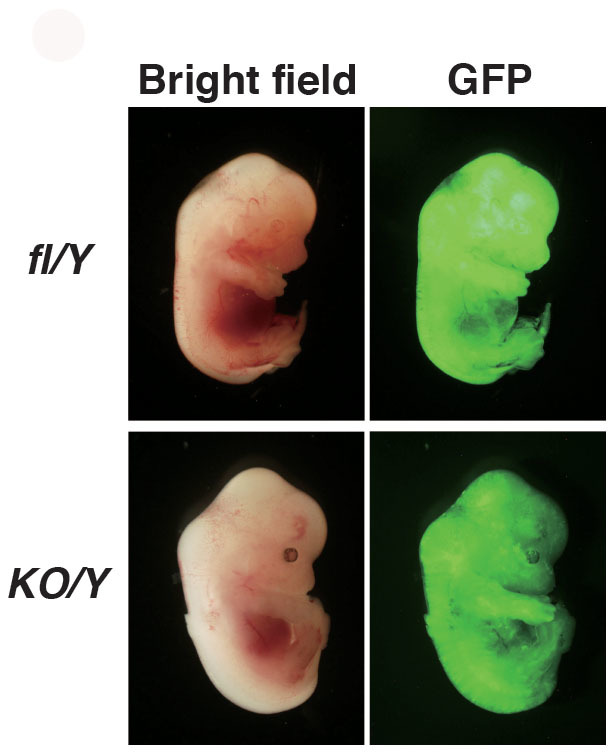
Chimeric embryos with Nr0b1-null ES cells.Chimeric embryos at 13.5 dpc obtained by injection of Nr0b1fl/Y (fl/Y) and Nr0b1KO/Y (KO/Y) ES cells carrying constitutively-active Egfp transgene.